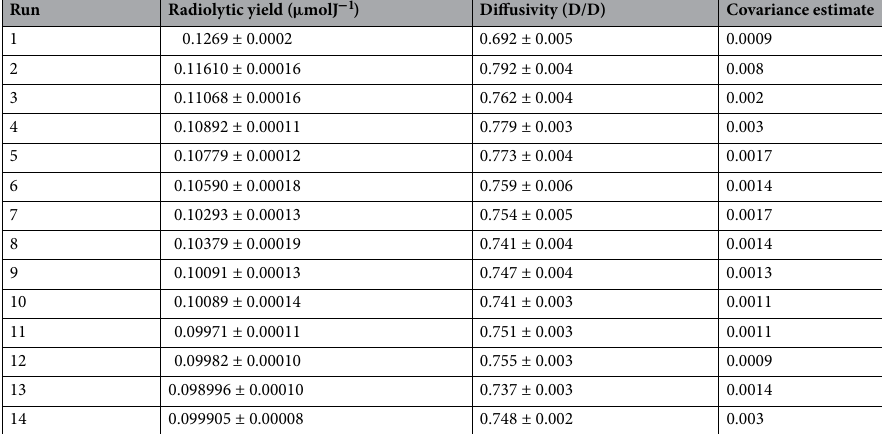
Table 1. The fitted results, and associated errors, for the runs plotted in Fig. 3. The covariance estimate between the fitted diffusivity and fitted radiolytic yield is also reported. The runs are in chronological order. The radiolytic yield determined from this data set was (0.107 ± 0.004) µ mol J a ratio of the hydrogen diffusion coefficient through the sludge to the hydrogen diffusion coefficient in water is 0.754 ± 0.014. The measured radiolytic yields indicate an observed radiolytic consumption of (27 ± 6) nmol − 1 J . This gives a lower bound for the radiolytic consumption rate of (0.22 ± 0.08) nmolJ change between the initial and second radiolytic yield, which would only hold if all the produced hydrogen remained in the irradiated